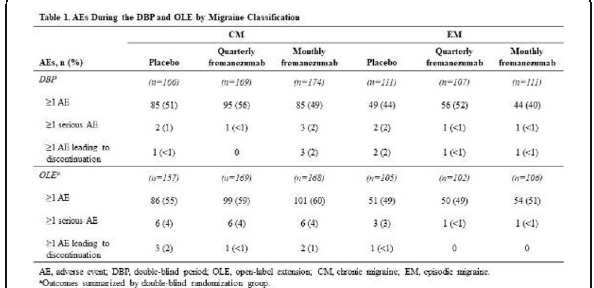
Fig. 1 (abstract P0327). See text for description